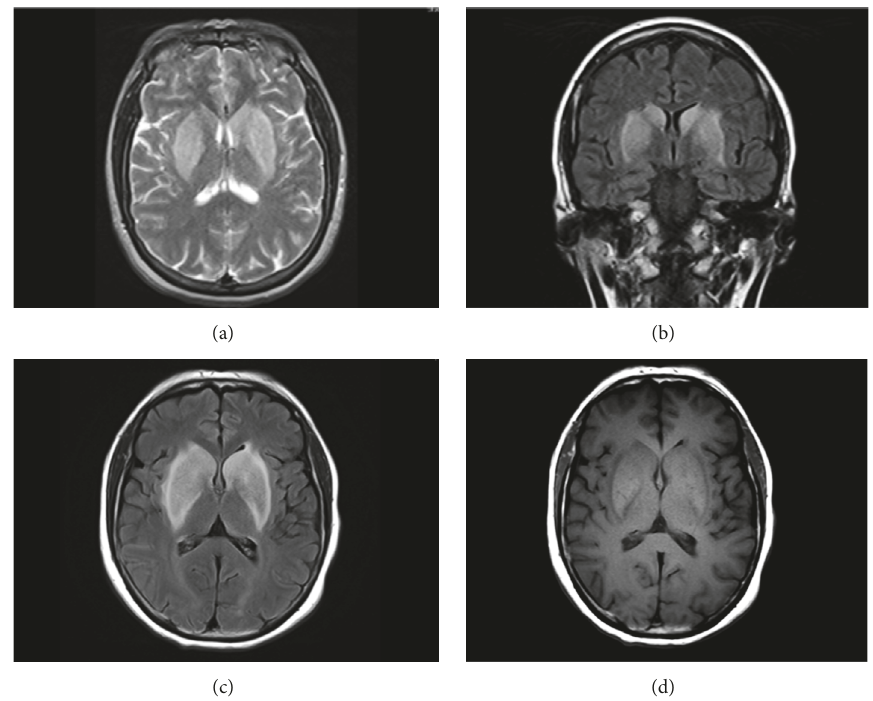
Figure 1: Initial and follow-up MRI brain for Case 1. (a) Initial MRI: axial T2-weighted image with hyperintensities in the bilateral basal ganglia. (b) Initial MRI: coronal FLAIR-weighted image with hyperintensities in the bilateral basal ganglia. (c) Follow-up MRI: axial FLAIR- weighted image with hyperintensities in the bilateral basal ganglia. (d) Follow-up MRI: axial T1-weighted image with hyperintensities in the bilateral basal